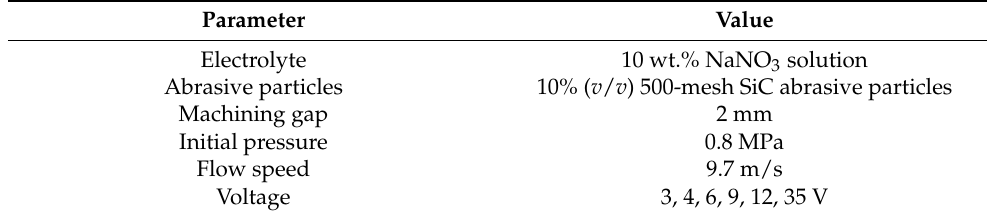
Table 3. Experimental parameters of ECFAP